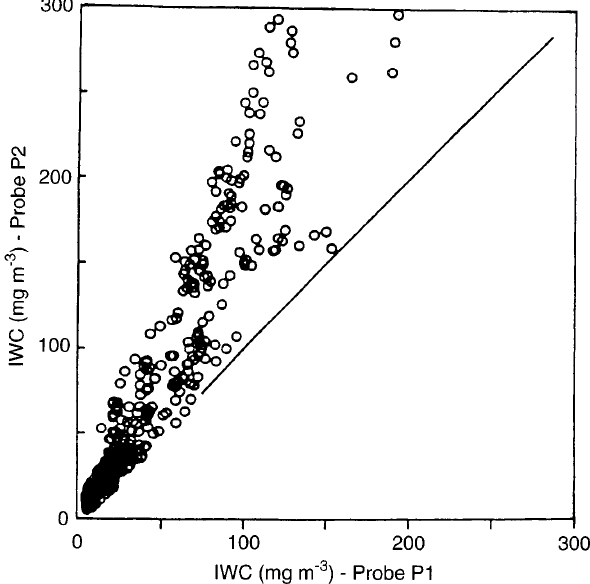
Fig. 7. Comparison of the IWC obtained from two PMS 2D-C probes (P1, P2) mounted close together on the same aircraft (cirrus